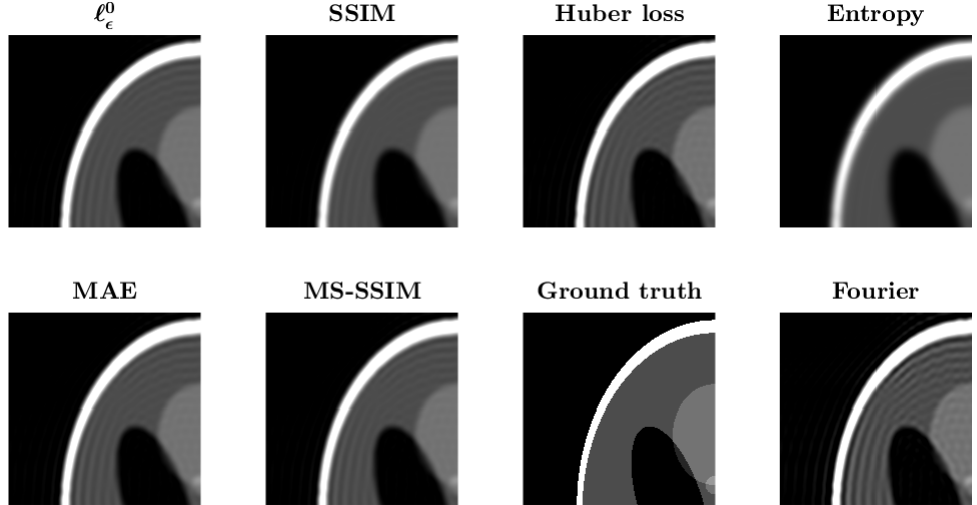
Figure 4. The optimal reconstructions of the Shepp–Logan phantom from the different metrics. For reference, we also show the ground truth without ringing and the Fourier reconstruction with added